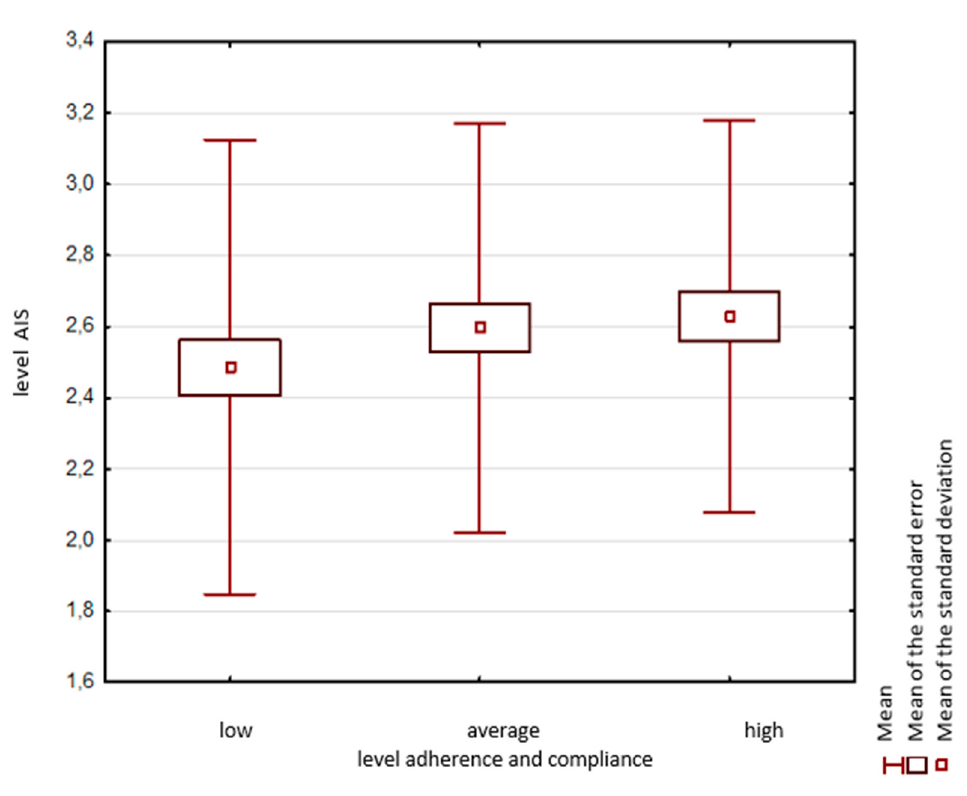
Figure 2. Distribution of AIS mean scores in adherence and compliance groups; Use of the ©MMAS